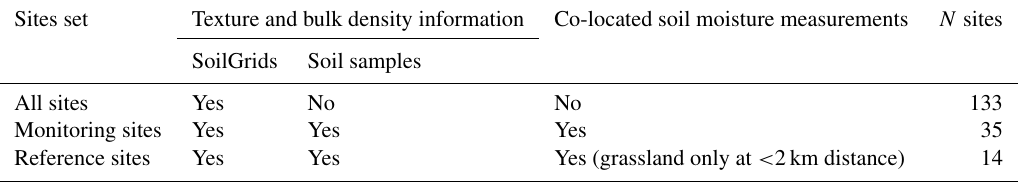
Table 1. Sets of sites, available data sets and number of sites. Sites set Texture and bulk density information Co-located soil moisture measurements N sites SoilGrids Soil samples All sites Yes No No 133 Monitoring sites Yes Yes Yes 35 Reference sites Yes Yes Yes (grassland only at < 2km distance)